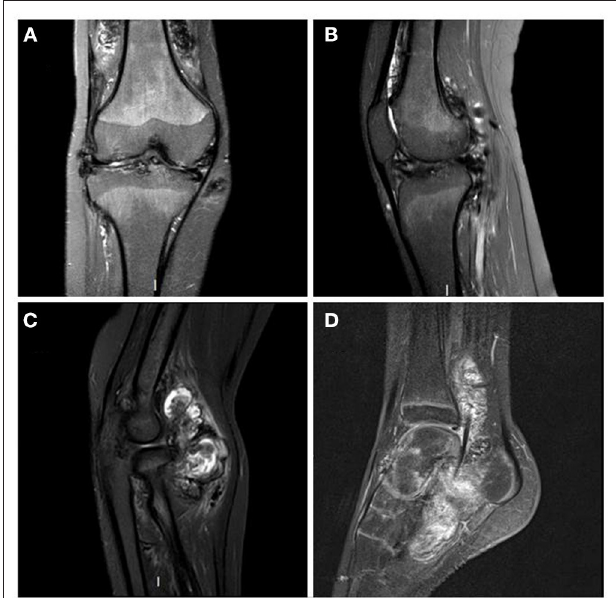
FIGURE 1 | MRI T1 Fat Sat sequences - right knee in coronal plane (A) and right knee in sagittal plane (B) : diffuse synovial pannus, especially in the superior recess of the joint. Tri-compartmental chondropathy associating stage IV chondrolysis associated with multiple subchondral cysts; STIR sequence of the right elbow in sagittal plane (C) : anterior intra-articular synovial masses in heterogeneous signal; T1 sequence after gadolinium injection of left ankle in sagittal plane (D) : Large synovial panuses mainly affecting the subtalar joint and voluminous synovial masses developed around the long plantar flexor hallucis behind the lower end of the tibia. These signs were highly suggestive of multifocal villonodular synovitis which was later confirmed by histopathological examination.